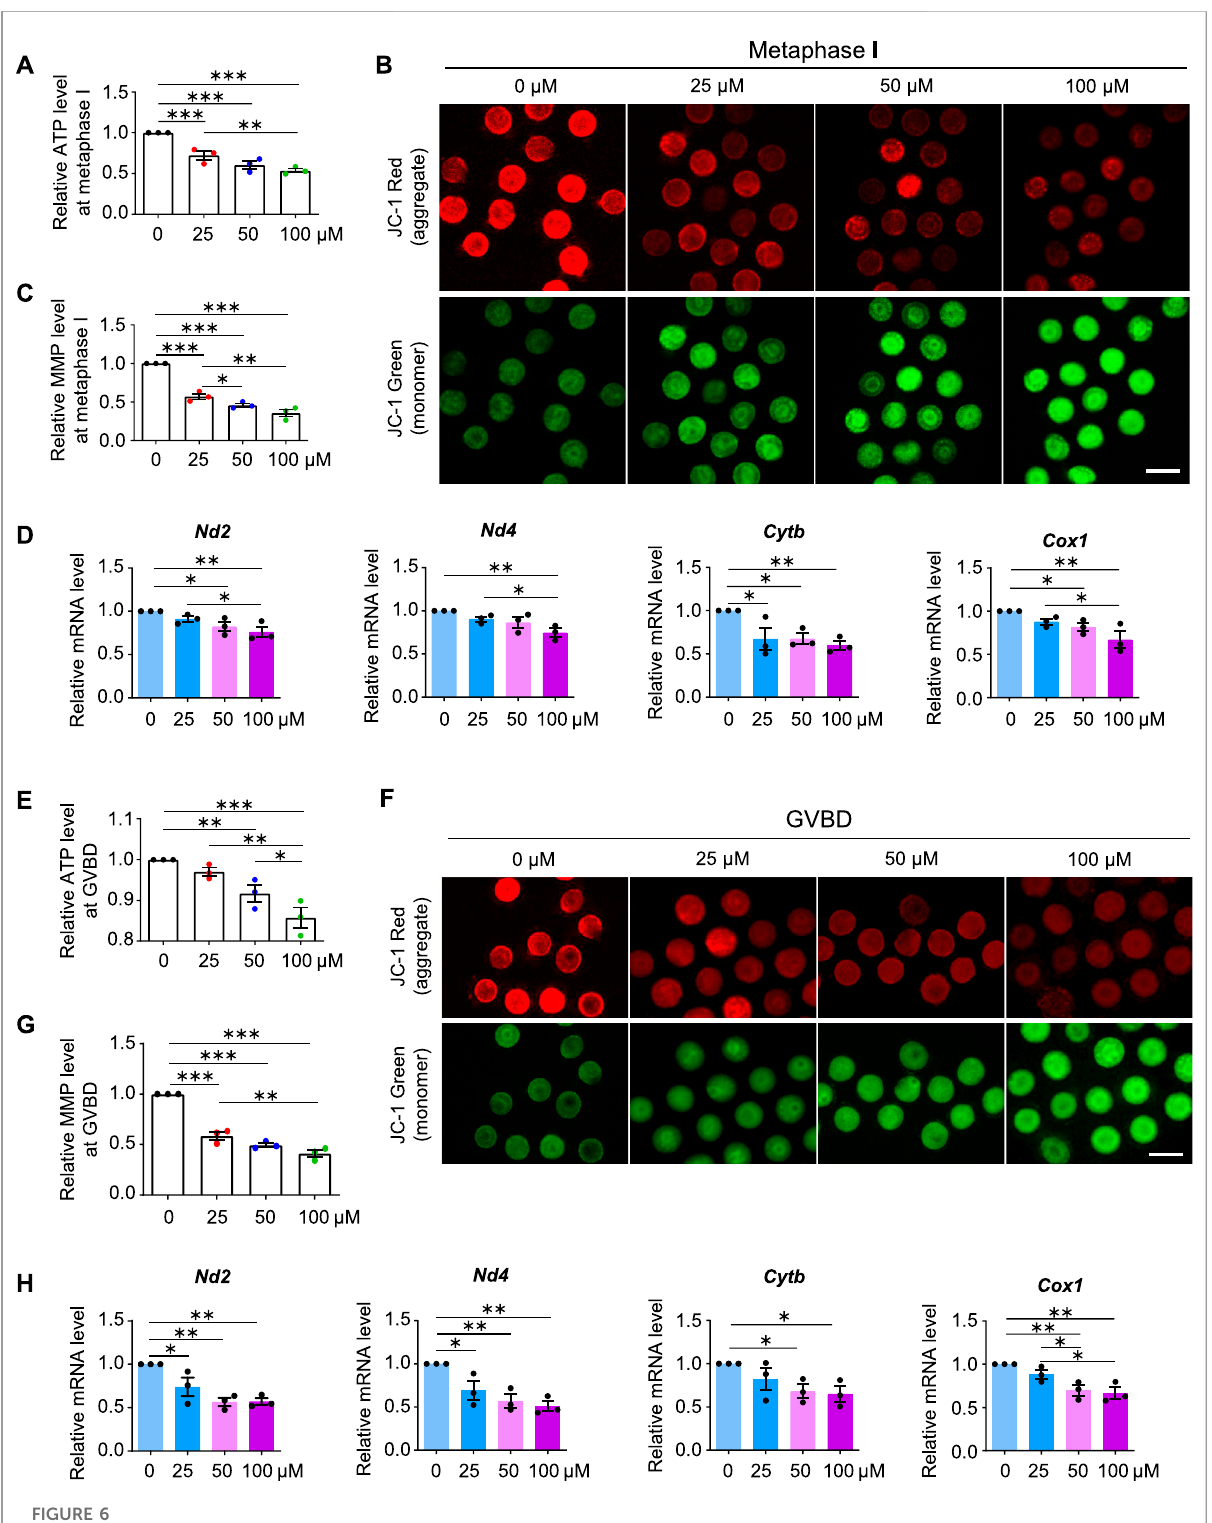
AAIexposuredecreasesmitochondrialmembranepotential(MMP)andATPproduction. (A) TheGVoocyteswerematuredfor8 htoreachMIin theM16medium with0, 25, 50,and 100 μ MAAI.Oocyteswerecollected andthe fi re fl yluciferase assay wasperformed to examine theATPcontent. The relative ATP contents in MI oocytes matured in different treatments were shown. (B,C) Representative images of JC-1 assay (B) and quanti fi cation (C) of the MMP in MI oocytes. MMP was calculated as the intensity ratio of red fl uorescence (J-aggregate) to green fl